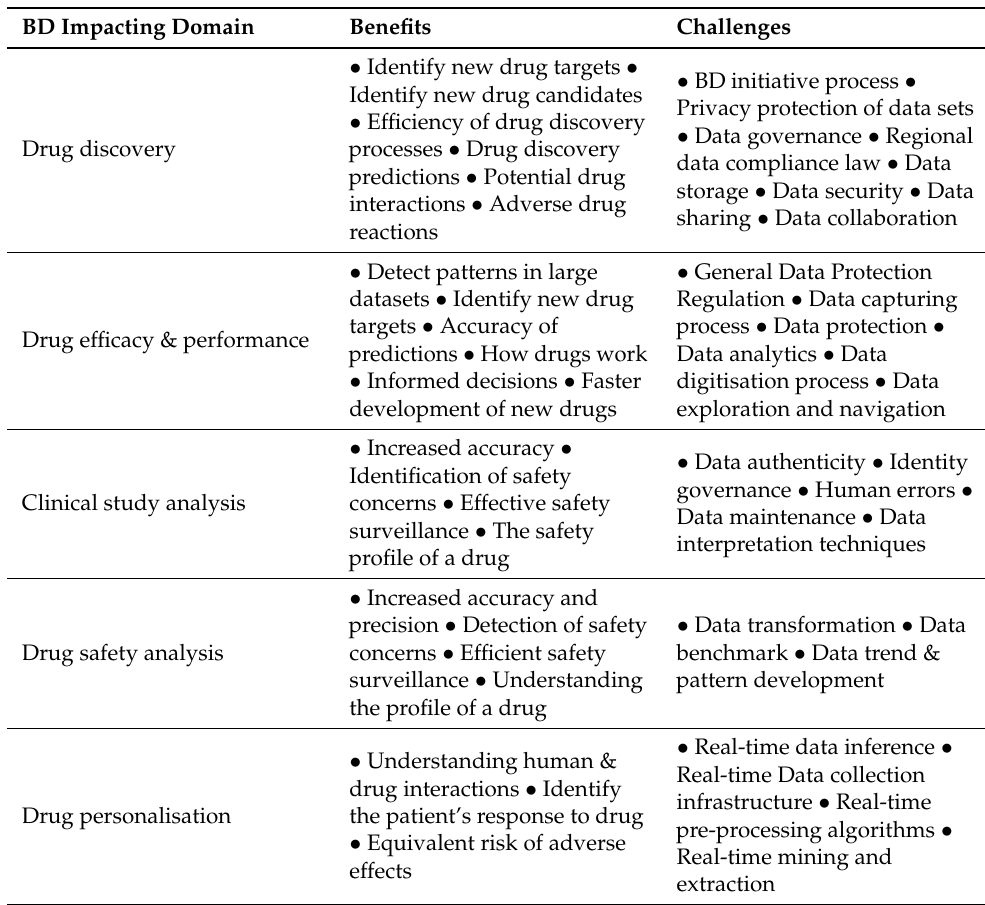
Table 2. Challenges and future